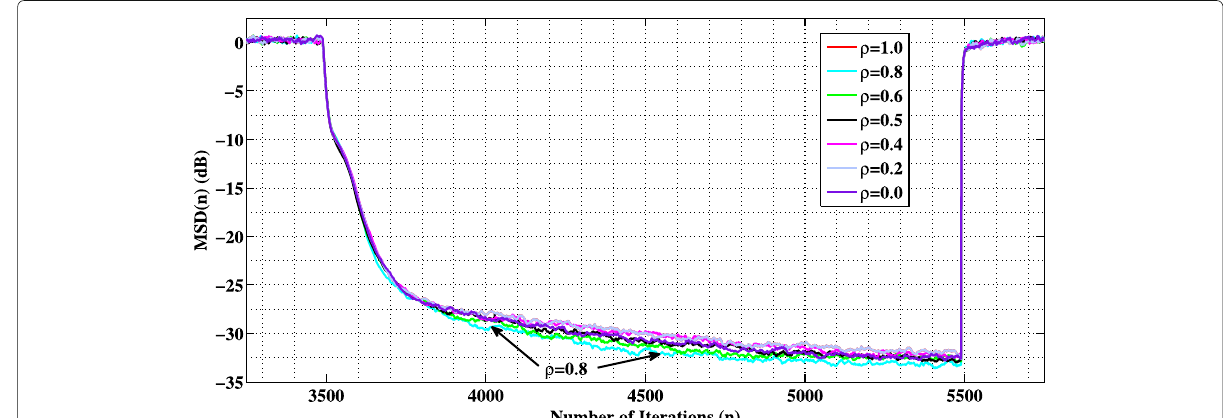
Fig. 19 Effect of momentum term on the MSD performance of the D-CFLF scheme when input signal is white noise